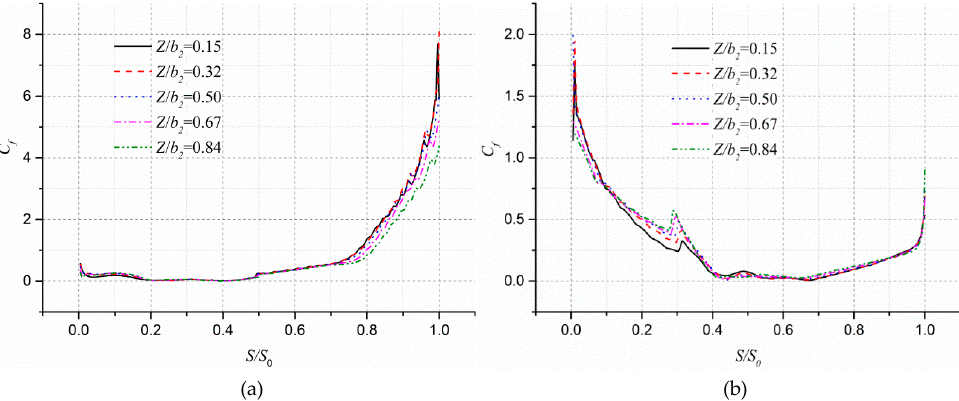
Figure 14. Comparison of the skin friction coefficient on the blade surface at different axial cross sections: ( a ) pressure surface and ( b ) suction surface. sections: ( a ) pressure surface and ( b ) suction